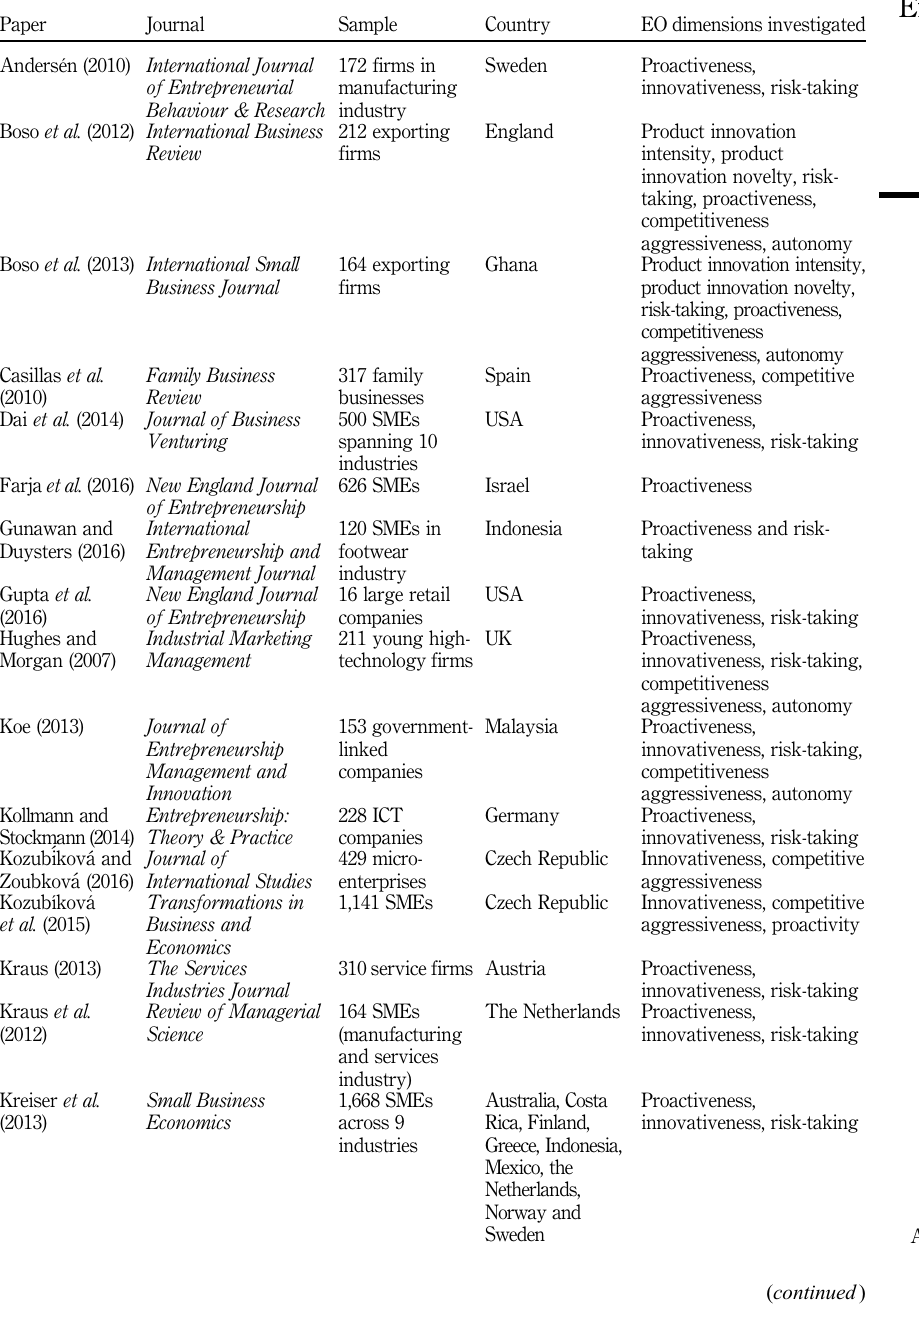
Table I. Articles examining EO dimensions-